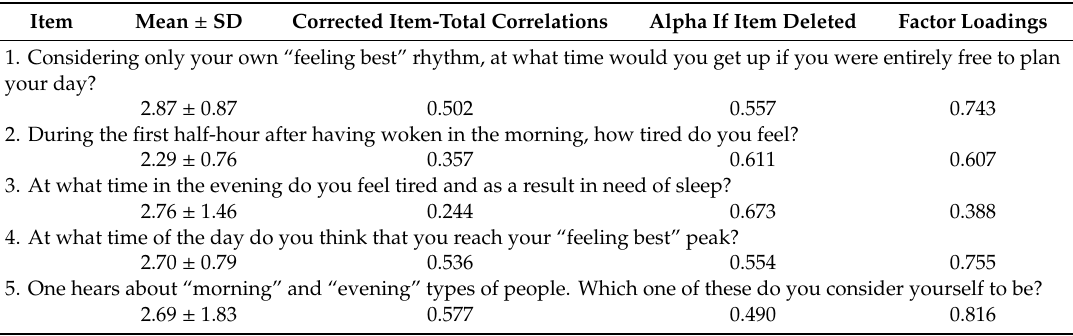
Table 1. Item means and standard deviations, corrected item-total correlations, alpha if items deleted and factor loadings of the items of the Croatian rMEQ ( n = 712).